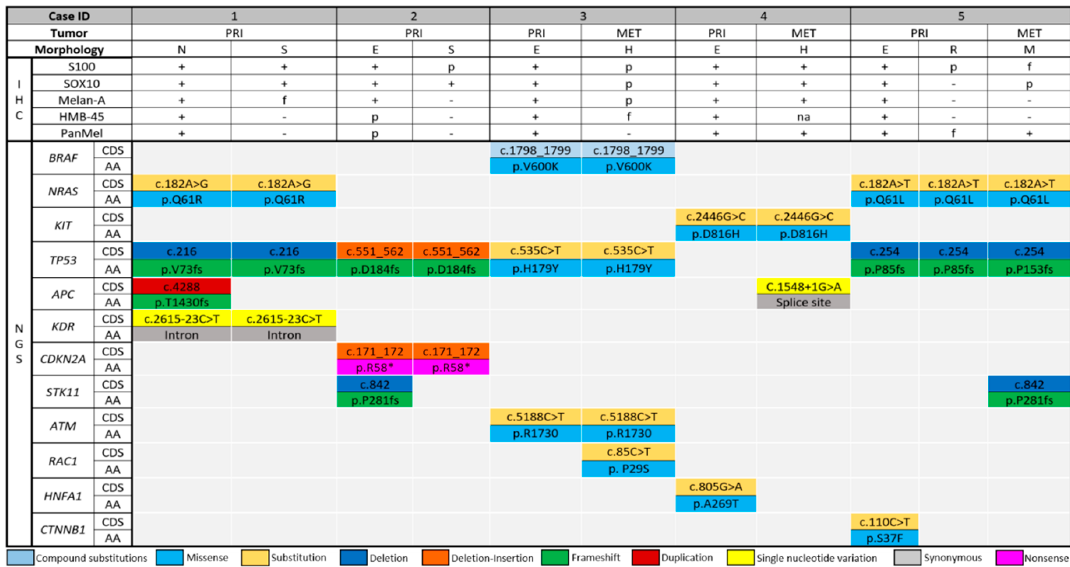
Figure 3. Next-generation sequencing of the histologically distinct regions revealed heterogeneous distribution of the detected cancer-associated driver mutations. In each mutated gene, specific changes detected at the nucleotide (CDS) and the peptide levels (AA), as well as sites of synonymous mutations, are illustrated. Abbreviations: PRI, primary; MET, metastatic; N, nevoid; S, spindled; E, epithelioid; H, histiocytoid; R, rhabdoid; M, myxoid; p, patchy; f, focal; na, not available.